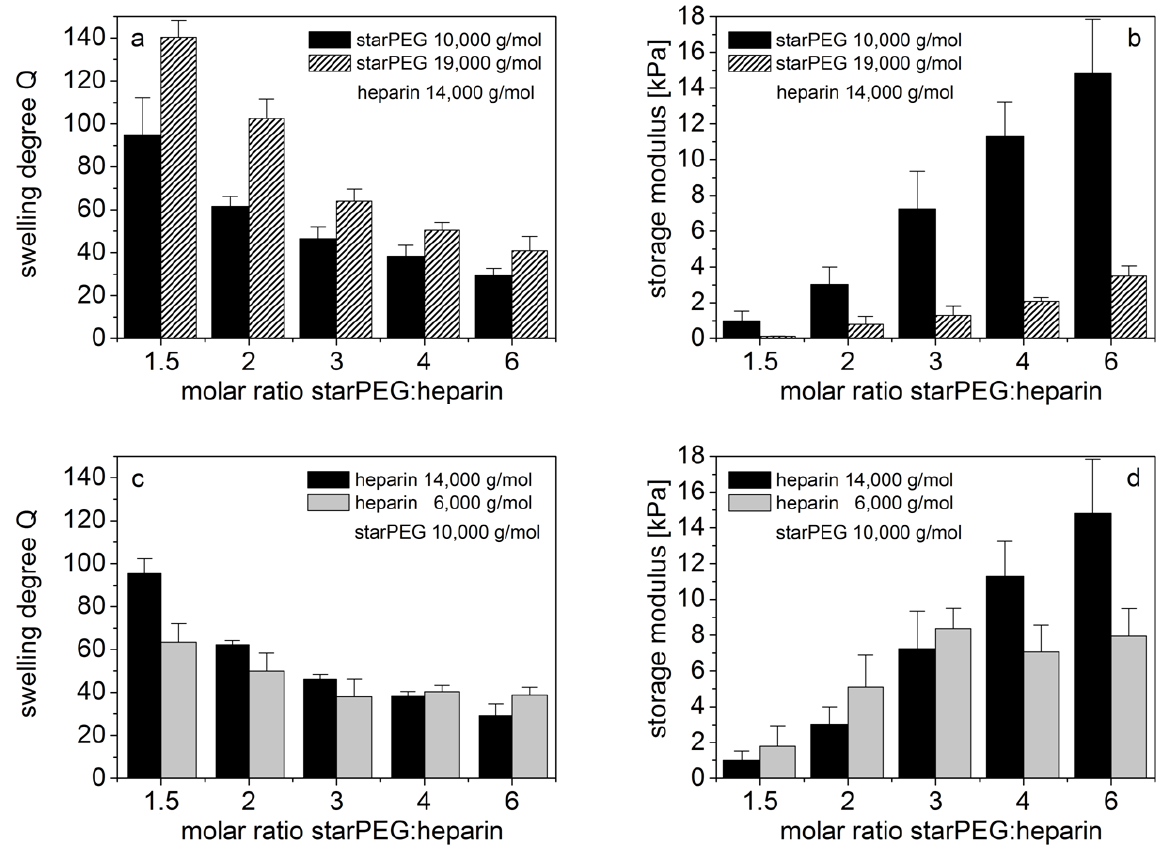
Figure 2. ( a ) Swelling properties of starPEG-heparin hydrogels. The ratio of wet volume to dry volume is reported for PEG10HEP14 and PEG19HEP14 hydrogels relative to the molar starPEG to heparin ratio in the polymer network. ( b ) Comparison of storage moduli for swollen PEG10HEP14 and PEG19HEP14 hydrogels relative to the starPEG to heparin ratio in the polymer network. ( c ) Swelling properties of starPEG-heparin hydrogels. The ratio of wet volume to dry volume is reported for PEG10HEP14 and PEG10HEP6 hydrogels. ( d ) Comparison of storage moduli for swollen PEG10HEP14 and PEG10HEP6 hydrogels relative to the starPEG to heparin ratio in the polymer